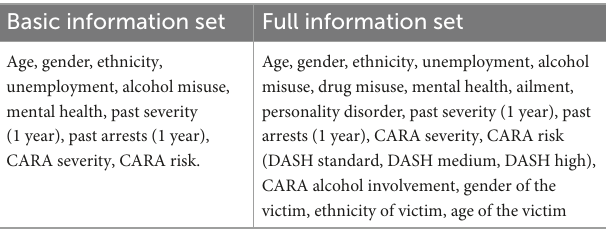
TABLE 7 Propensity score matching basic information sets (West Midlands Police).